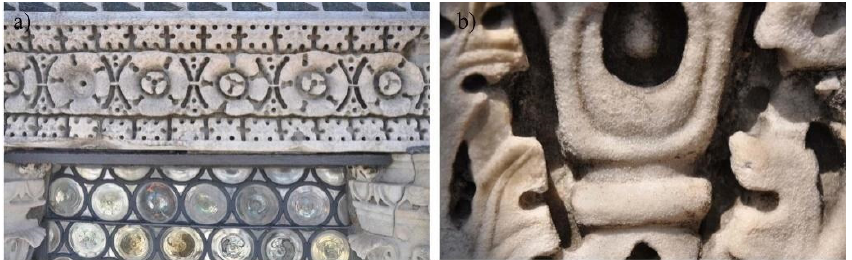
Figure 4. ( a ) An example of a widespread granular disintegration phenomenon (see detail in ( b )).